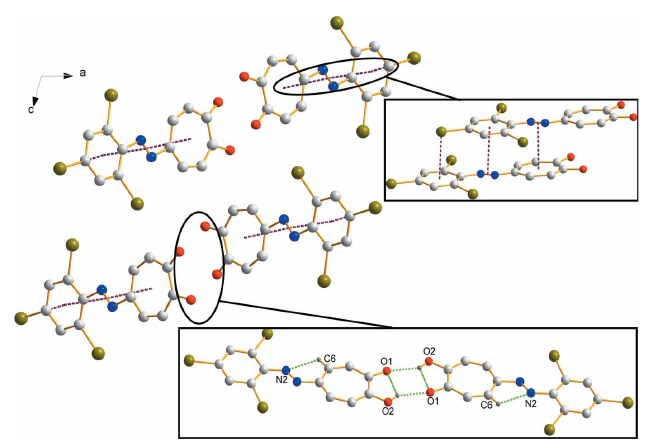
Figure 2 The packing of I as viewed along the b -axis. The top-right insert illustrates the Br (cid:2)(cid:2)(cid:2) (cid:2) and (cid:2) ! (cid:2) * CT interactions, while the bottom-right insert illustrates the O—H (cid:2)(cid:2)(cid:2) O and C—H (cid:2)(cid:2)(cid:2) N interactions as dashed bonds. Only selected hydrogen atoms are shown for clarity.